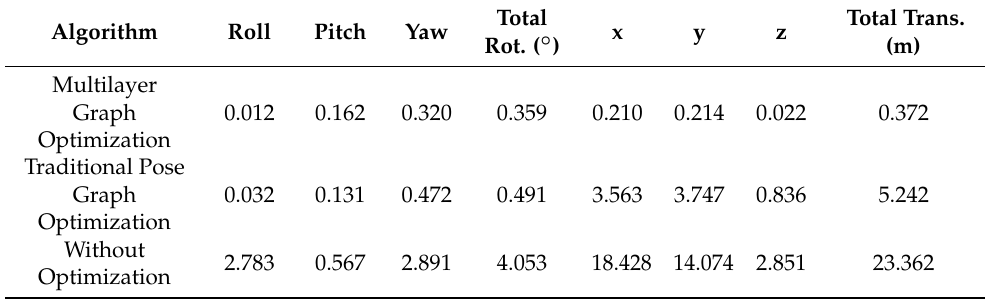
Table 5. Relative pose